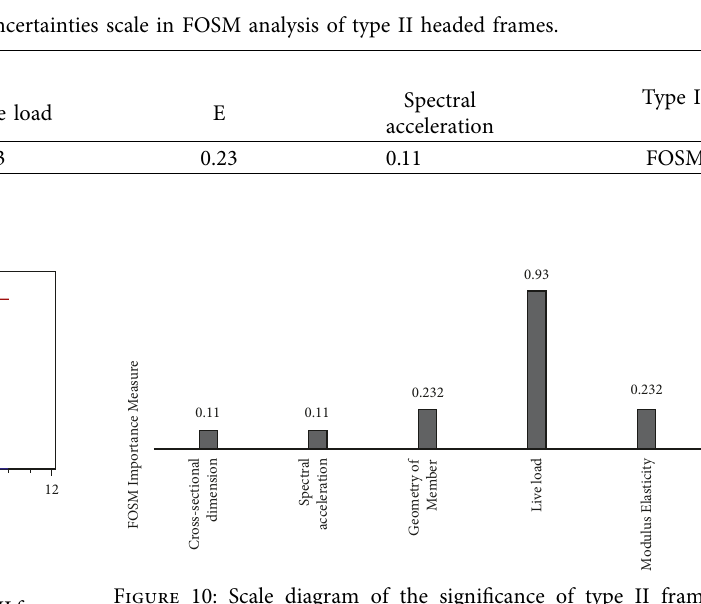
Figure 9: Convergence diagram of FORM analysis for type II frame in RT program.